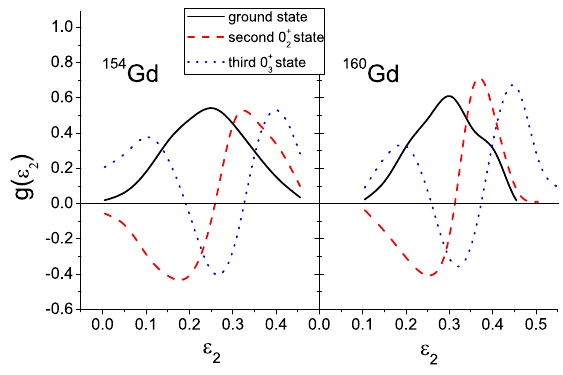
Figure 7. (Color online) Calculated distribution function of de- formation for the first three 0 + states in 154 Gd and 160 Gd. This figure is taken from Fig. 3 of Ref. [24].